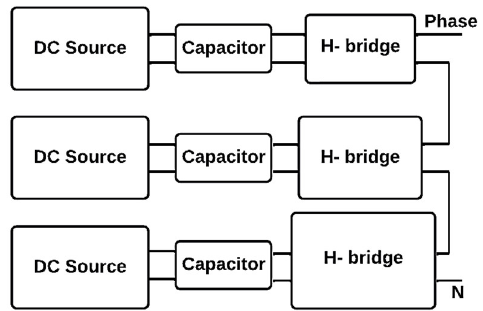
Figure 2. Independent cell construction considering the power transferred to the load.